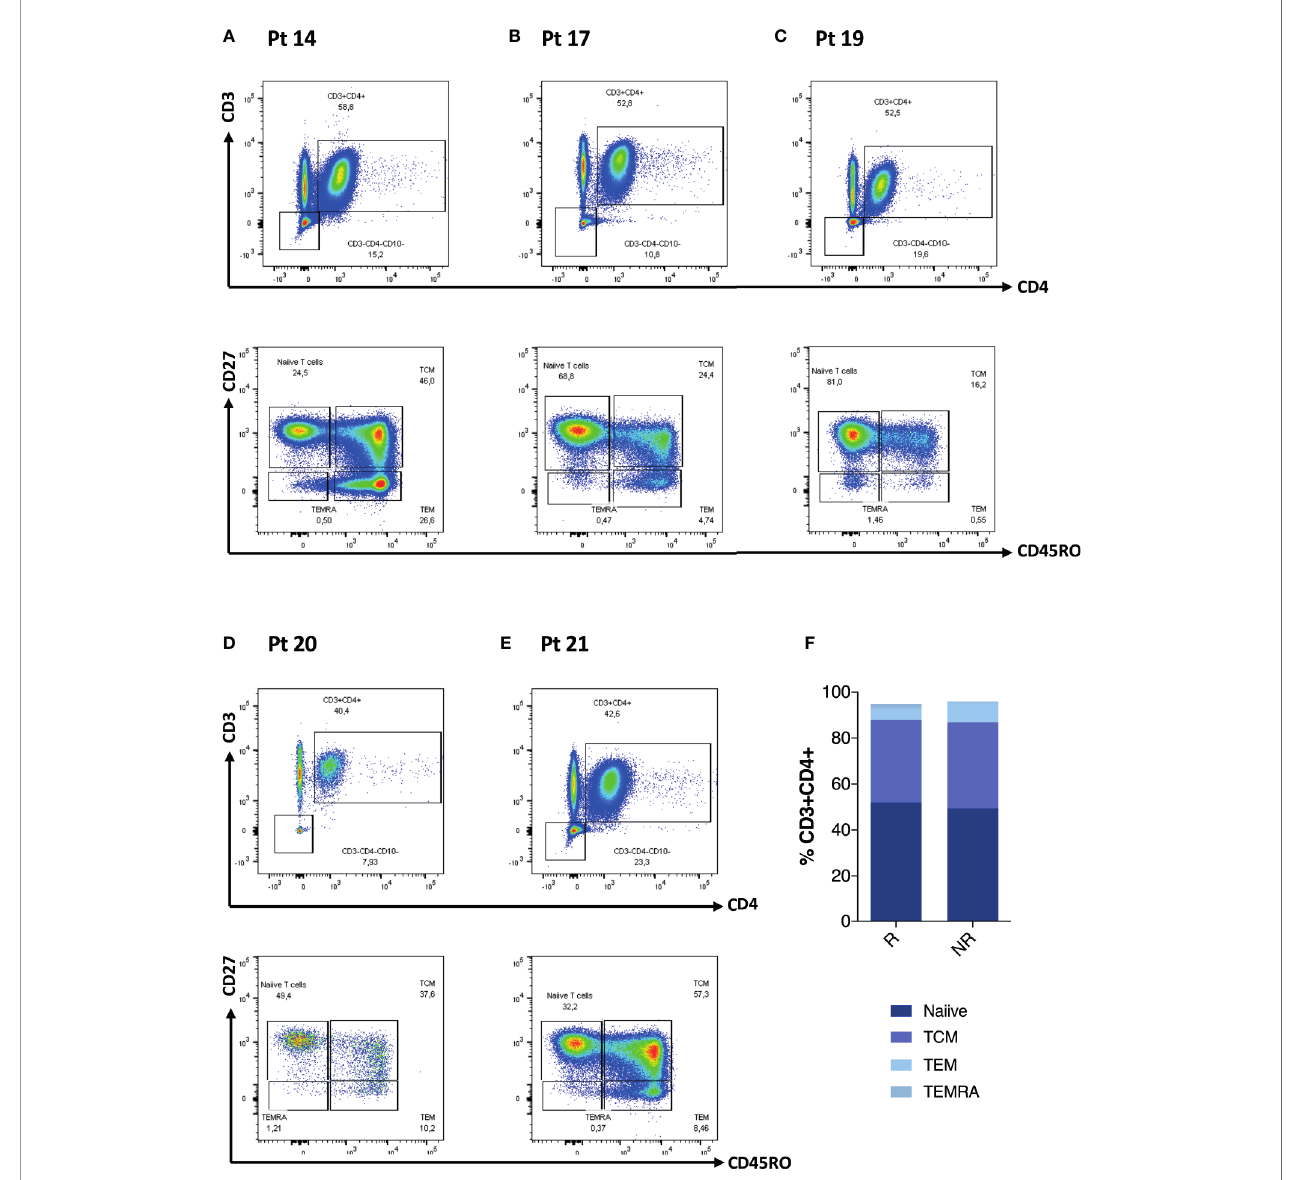
FIGURE 2 | CD4 T-cell phenotype characteristics of fi ve patients lacking any cellular response is reported in (A – E) . Non-paired non-parametric Mann – Whitney test was used to assess differences in the levels of each sub-population in (F)